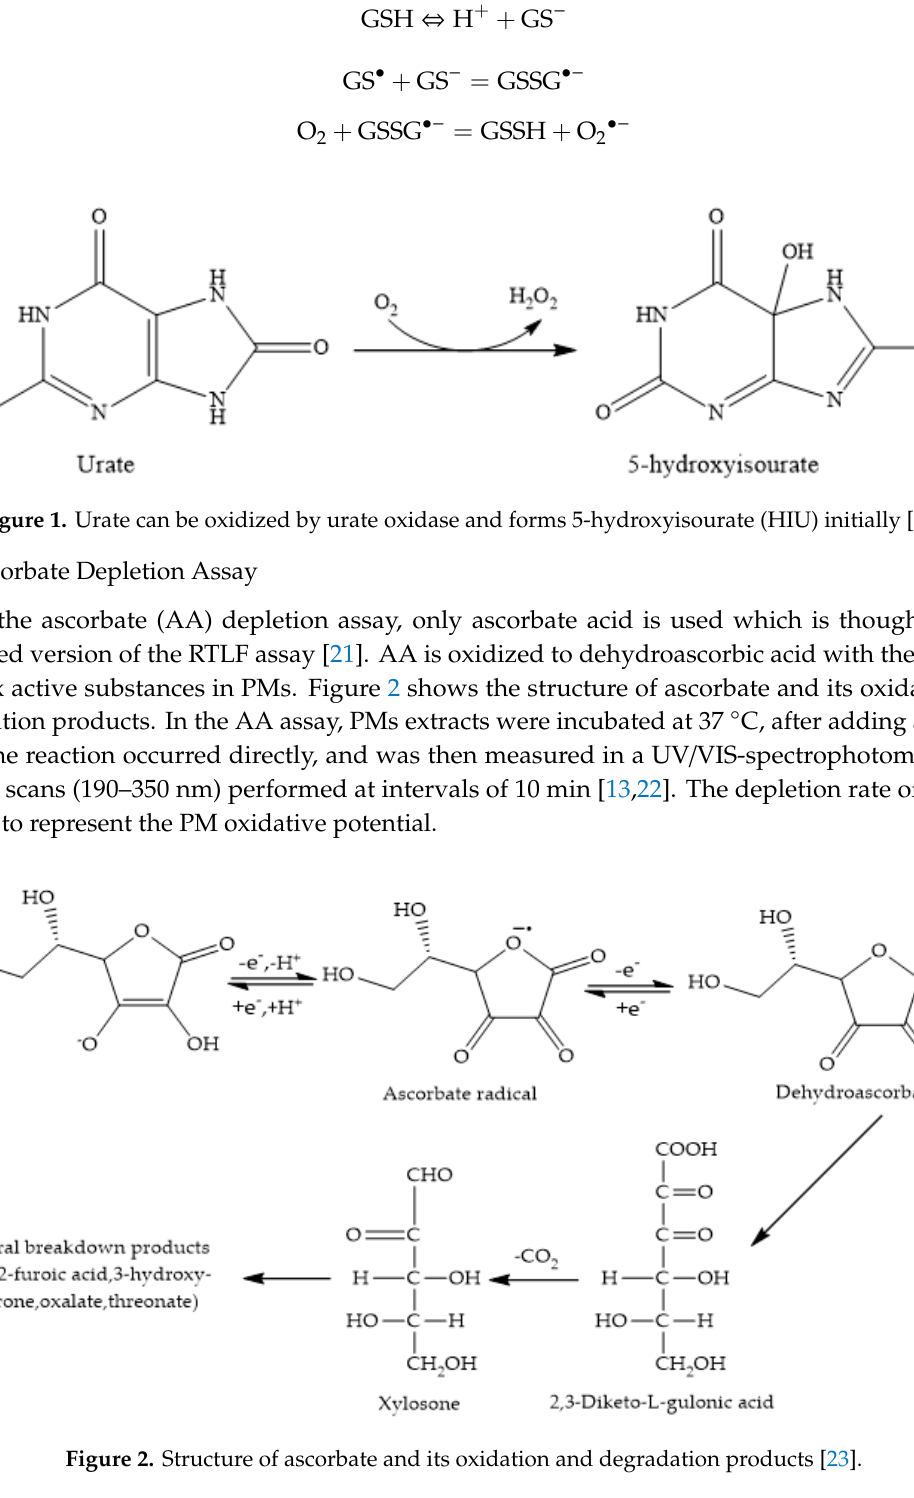
Figure 1. Urate can be oxidized by urate oxidase and forms 5-hydroxyisourate (HIU) initially [20].